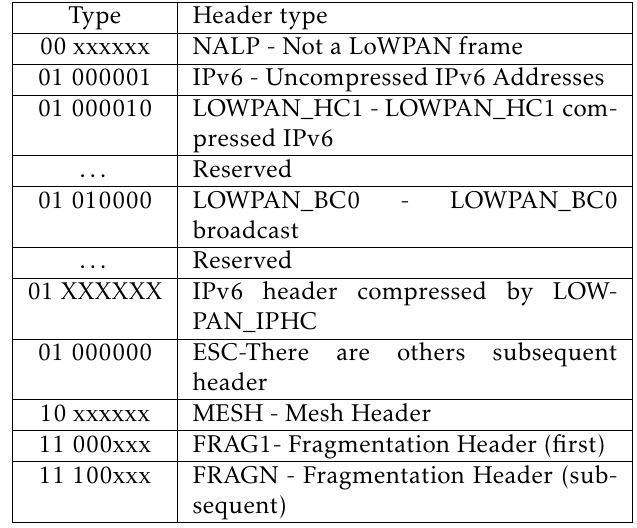
Table 1. 6LoWPAN dispatch